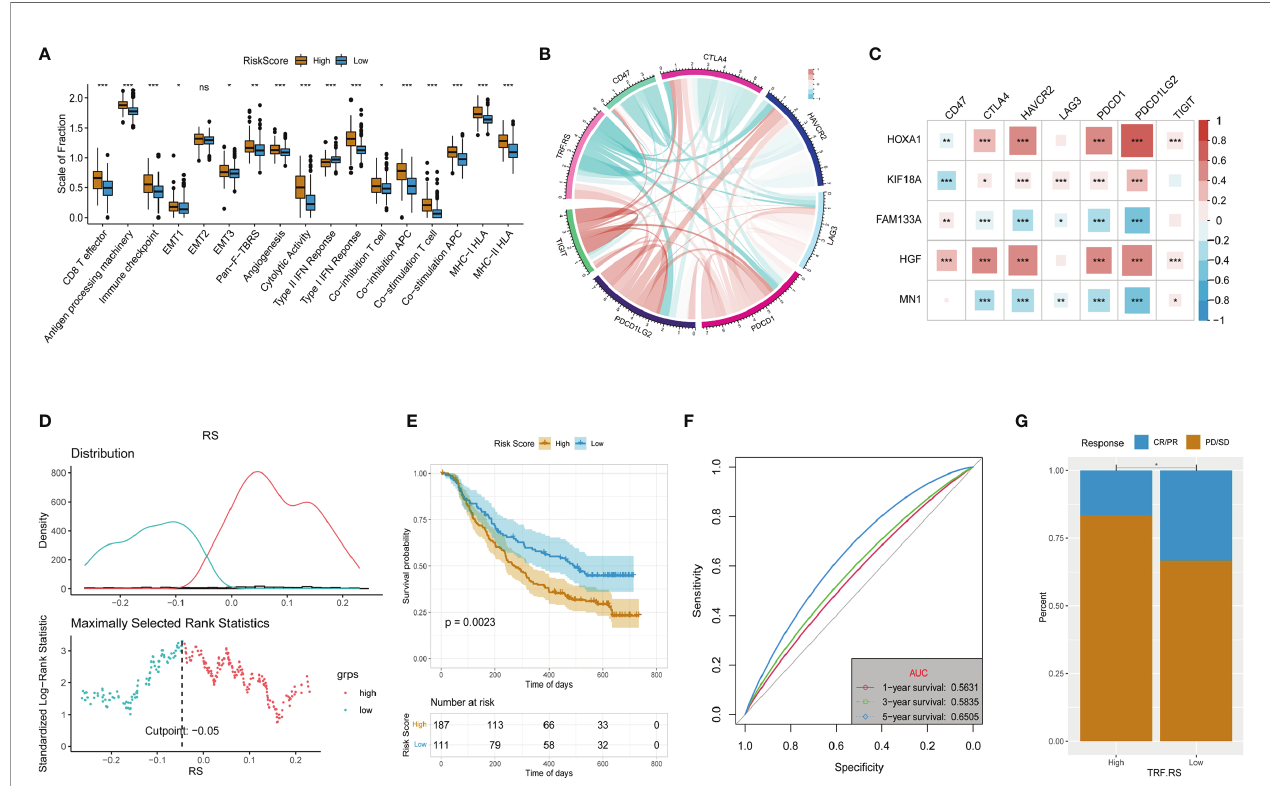
FIGURE 10 | Evaluation of the response to immunotherapy. (A) Comparation of the immune response signature between the high- and low-risk groups. (B) Corelationships between the Tumor Recurrence Factor risk score and common immune checkpoints. (C) Corelationships between the 5 key genes and common immune checkpoints. (D) Determine the optimal cut point for the Tumor Recurrence Factor risk score. (E) Comparison of the overall survival between the low and high Tumor Recurrence Factor risk score. (F) Receiver operating characteristic (ROC) curves showed the 1-, 3-, and 5-year predictive ef fi ciency of the Tumor Recurrence Factor risk score. (G) Comparison of the proportion of response to treatment between the low and high Tumor Recurrence Factor risk score. "*" means 0.01<p<0.05, "**"means 0.001<p<0.01, "***"means p<0.001,"ns"means no signi fi